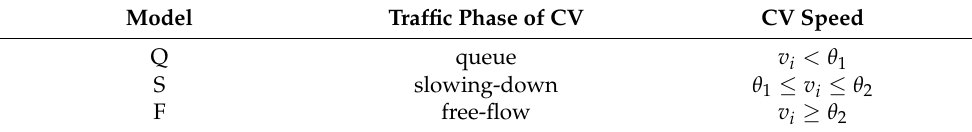
Table 3. Criteria for clustering the CVs closest to the stop-bar in the disaggregated